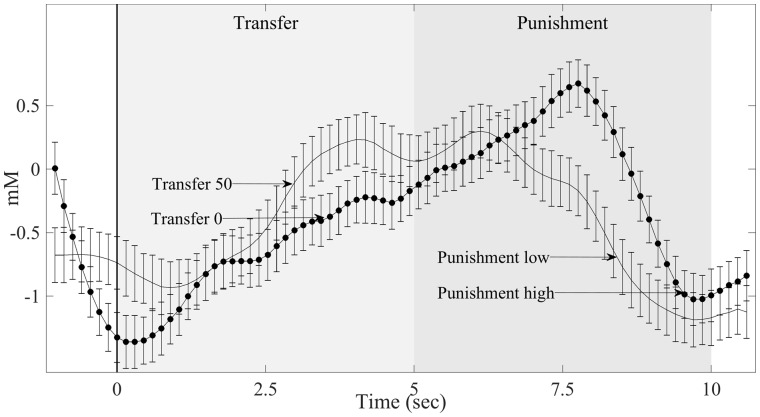
Condition-specific neural example data. Event-triggered hemodynamic dlPFC response from one participant. Data are shown separately for minimum (0) and maximum (50) transfers. Minimum transfer subsequently elicited stronger dlPFC activity and higher punishment than maximum transfer. Data are averaged across trials and aligned to the onset of the transfer phase (vertical black line). Error bars indicate SEM.